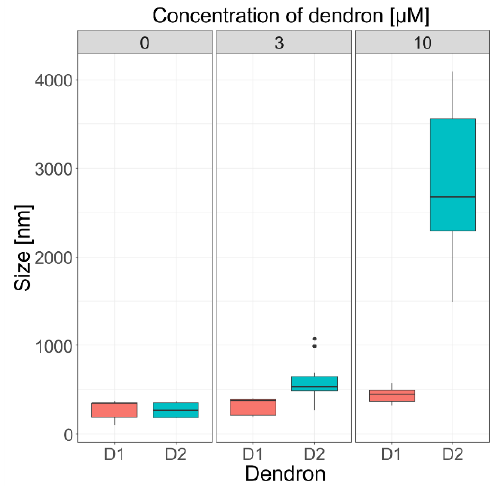
Figure 5. Boxplots showing average Z-size of liposomes with different concentrations of added D1 and D2 dendrons (c = 0 µM, 3 µM, and 10 µM).